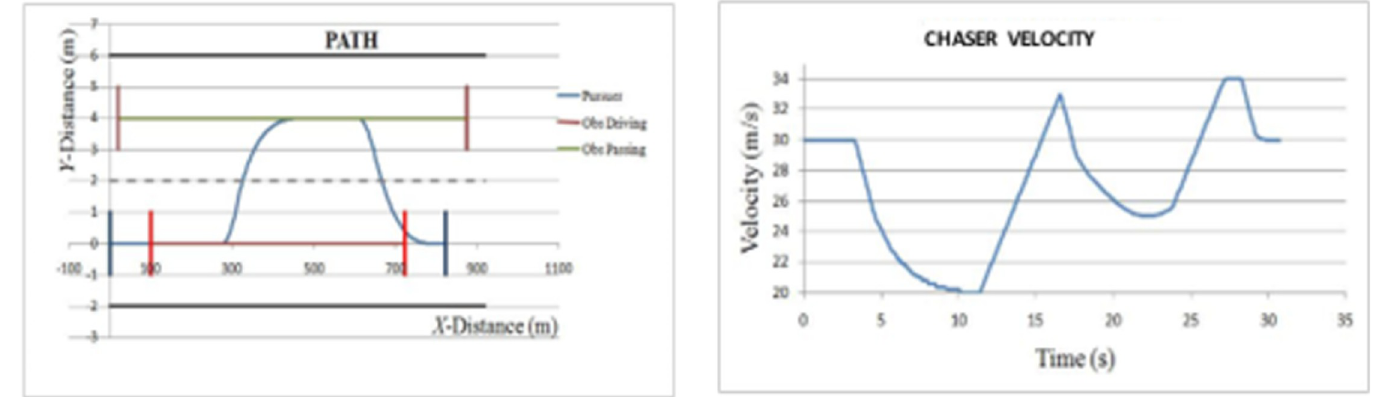
Fig 10. Profiling–velocity and path for C in scenario 2.